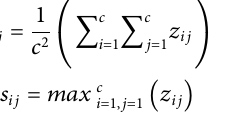
Frontiers in Earth Science |